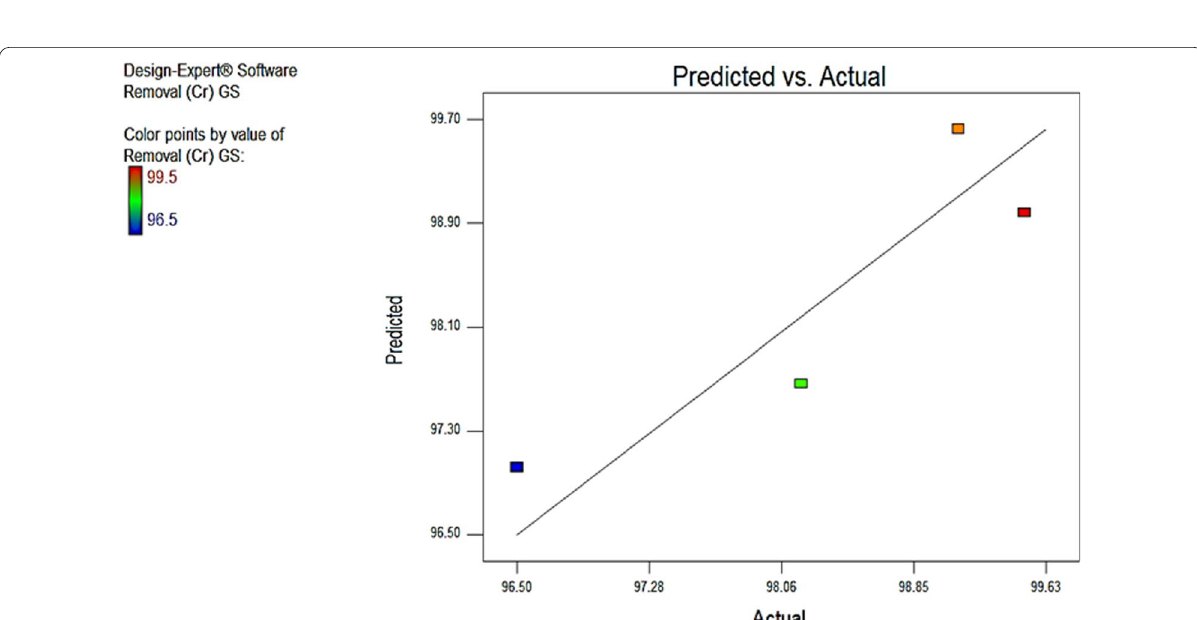
Fig. 7 A cross-validation plot predicted response against actual values of response from selected factorial model on the removal of chromium when groundnut shell residues are used as